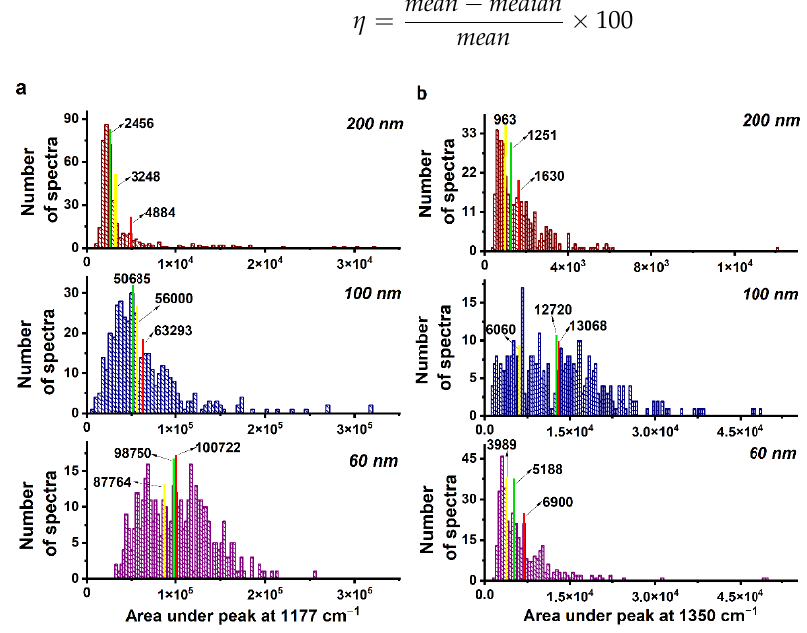
Figure 9. ( a ) Histograms of the distribution of the area value of the MG SERS peak at 1177 cm −1 . ( b ) Histograms of the distribution of the area value of the phthalocyanine SERS peak at 1350 cm −1 . In this case, the main factor affecting the recording of a high-intensity SERS spectrum may be the angular dependence between the hot spot and the phthalocyanine molecule (at which angle the molecule was adsorbed relative to the hot spot region). Due to their high elasticity, NWs with diameters of 60 and 100 nm form agglomerates, consisting of a large number of leaning NWs. In such a bundle of leaning NWs, different angles between their tips may appear, which would also affect the nature of the hot-spot formation and subsequent amplification of the SERS spectra. The fact that the main factor in the amplification of the SERS spectra of macromole- cules exemplified by phthalocyanine is precisely the angular dependence rather than the area of the enhancing surface, is demonstrated in Figure 7. For phthalocyanine molecules with a concentration of 10 mM, there are distribution patterns of the area under three characteristic peaks on substrates with NWs of 60, 100 and 200 nm in diameter. Let us take a closer look at the SERS-mapping of the peak at 1350 cm −1 . The enhancing areas are 63%, 77%, 61%, and the relative shifts of the mean value ( n ) are nearly 25%, 3%, 23% for sub- strates with NWs of 60, 100, and 200 nm in diameter, respectively (see Table 1). The values for NW substrates with diameters of 60 and 200 nm practically coincide, while for a NW with a diameter of 100 nm they differ significantly. In addition, for 100 nm diameter NWs, the value of the histogram mode differs by more than an order of magnitude from the corresponding values at 60 and 200 nm diameter NWs (Figure 9b). This confirms the hy- pothesis about the importance of the distribution of local electric fields near the leaning NW tips. Let us consider in more detail the intensity-distribution histogram for MG molecules adsorbed on the SERS substrate with 60 nm diameter NWs. In addition to the first peak on the histogram, which characterizes the SERS signals close to the spectral noise, two enhancement ranges can be distinguished: 1.0 5 – 1.4 5 and 1.4 5 – 2.5 5 . SERS-mapping images were plotted for these enhancement ranges, and there is a significant difference between them (Figure 10). Image analysis suggests that these areas correspond to different mecha- nisms of SERS amplification. The areas of the greatest enhancement correspond to hot spots of the gap type, which appear when the tips of two or more NWs lean toward each other at certain angles. They correspond to the horizontal stripes in the SERS-mapping